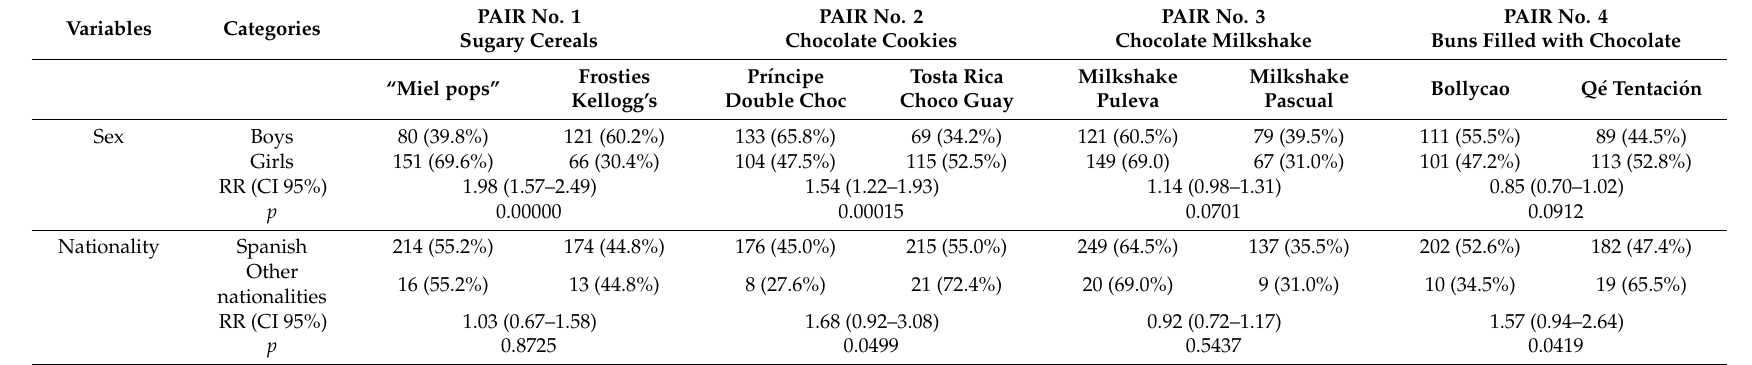
Table 2. Bivariate analyses of consumption preferences by sex and